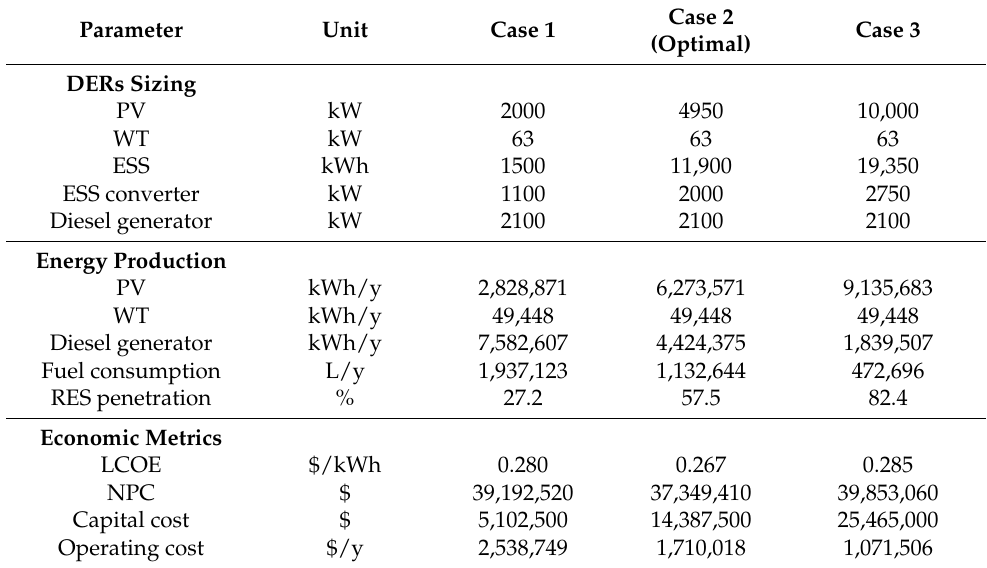
Figure 21. LCOE and NPC for various PV capacities considering real-time PV output curtailment. Table 7. Results of selected cases for Deokjeok Island microgrid considering real-time PV output